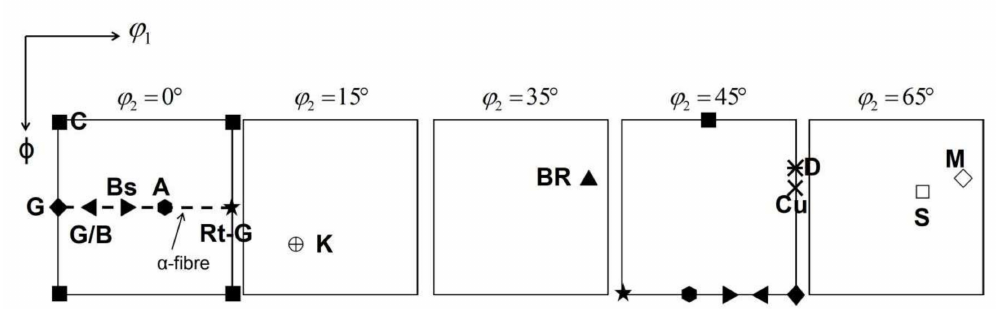
Figure 3. Schematic representation of important recrystallization texture components and α -fiber observed in the CoCrNi MEA, orientation distribution function (ODF) sections at φ 2 = 0 ◦ , 15 ◦ , 35 ◦ , 45 ◦ , and 65 ◦ .